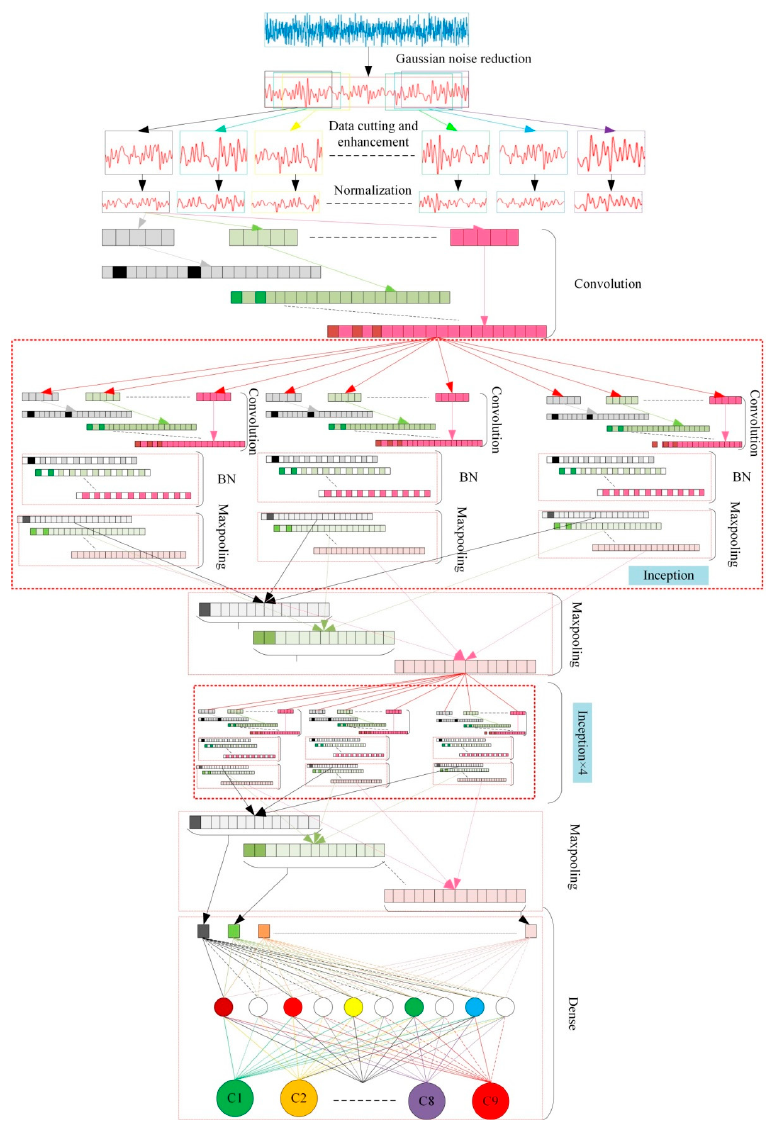
Figure 5. The schematic diagram of damage location diagnosis .